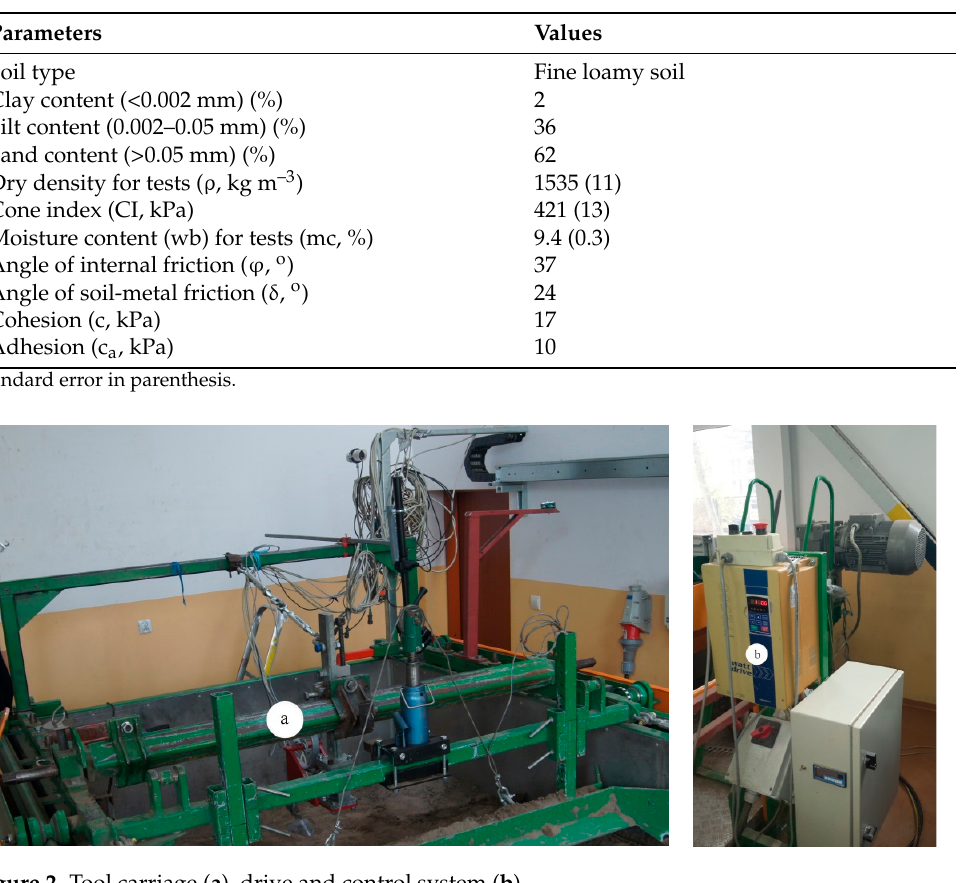
Table 1. Physical properties of the experimental soil.